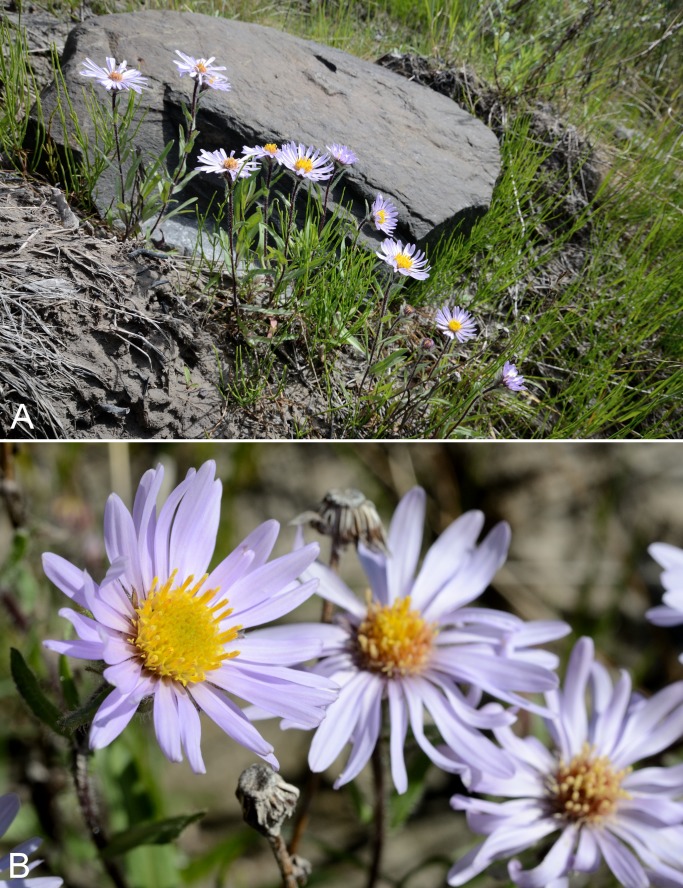
Symphyotrichum pygmaeum.(A) Habit, Saarela et al. 4219. (B) Capitula, Saarela et al. 4219. Photographs by R. D. Bull.